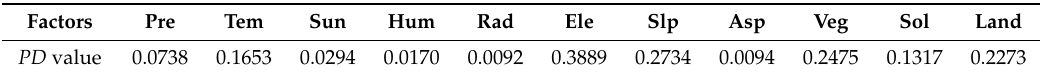
Table 4. The PD values of each factor.